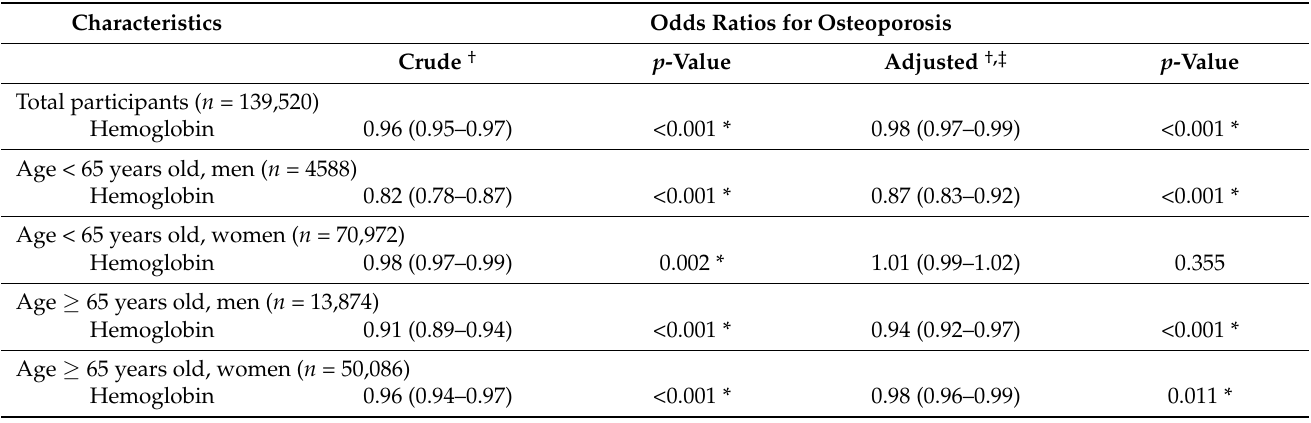
Table 2. Crude and adjusted odds ratios (95% confidence interval) for osteoporosis in hemoglobin according to age and sex. Characteristics Odds Ratios for Osteoporosis Crude † p